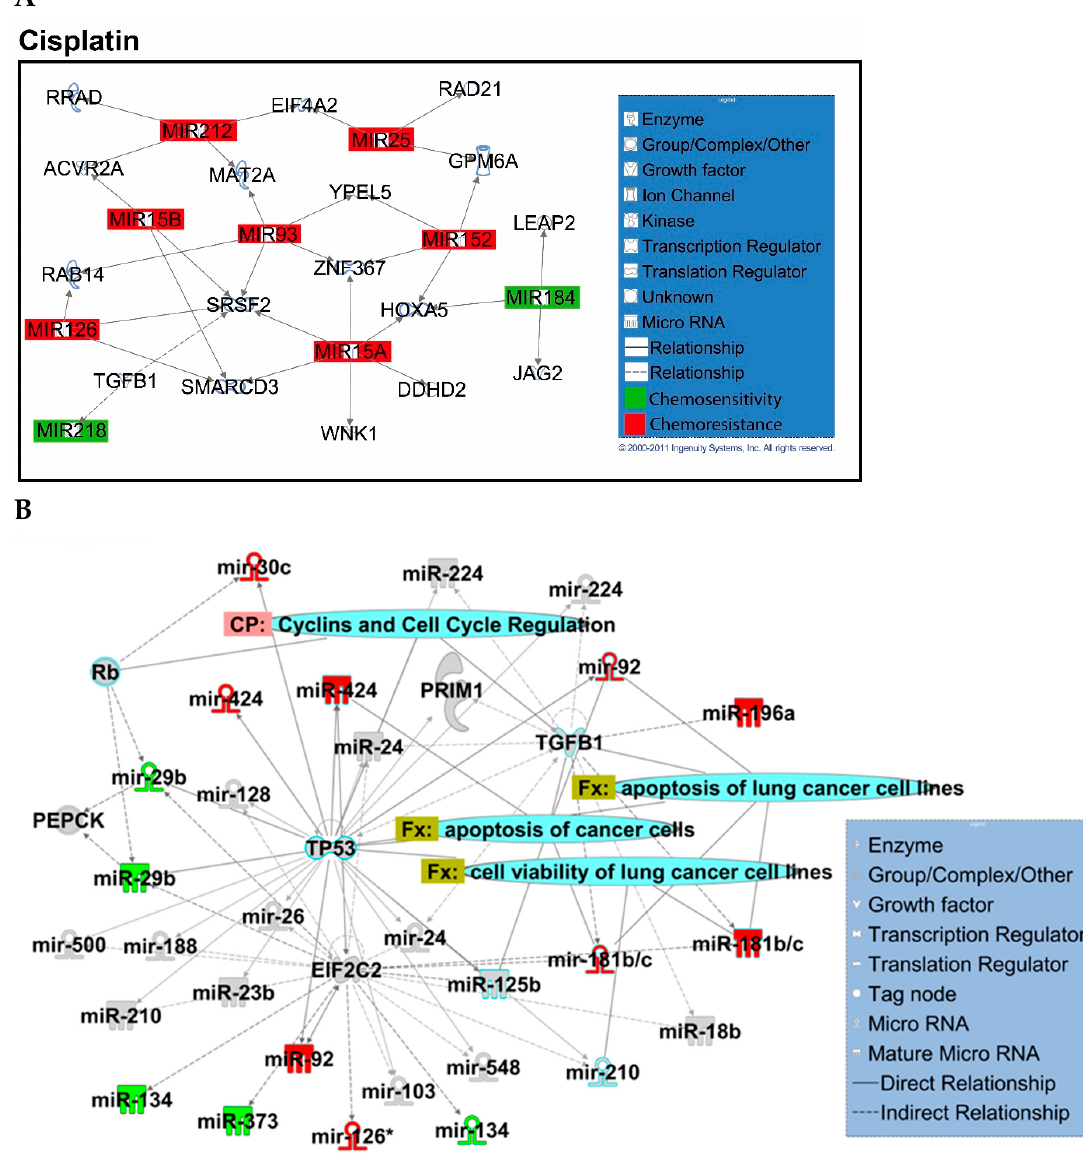
Figure A1. Overview of network derived from IPA Core analysis, representing interactions between miRNAs found to be chemopredictive for cisplatin and genes relevant to the significant functions and diseases listed in Tables 3 and 4. ( A ) miRNAs and their mRNA target genes. ( B ) Involvement of miRNAs in pathways, functions, and diseases. Canonical pathways (CP:) and functions and diseases (Fx:) as defined by IPA are overlaid to highlight the interconnectedness of the set with molecular processes relevant to chemoresponse. Predictive miRNAs whose expression was positively associated with survival are shown in green, and those whose expression was negatively associated are shown in red.